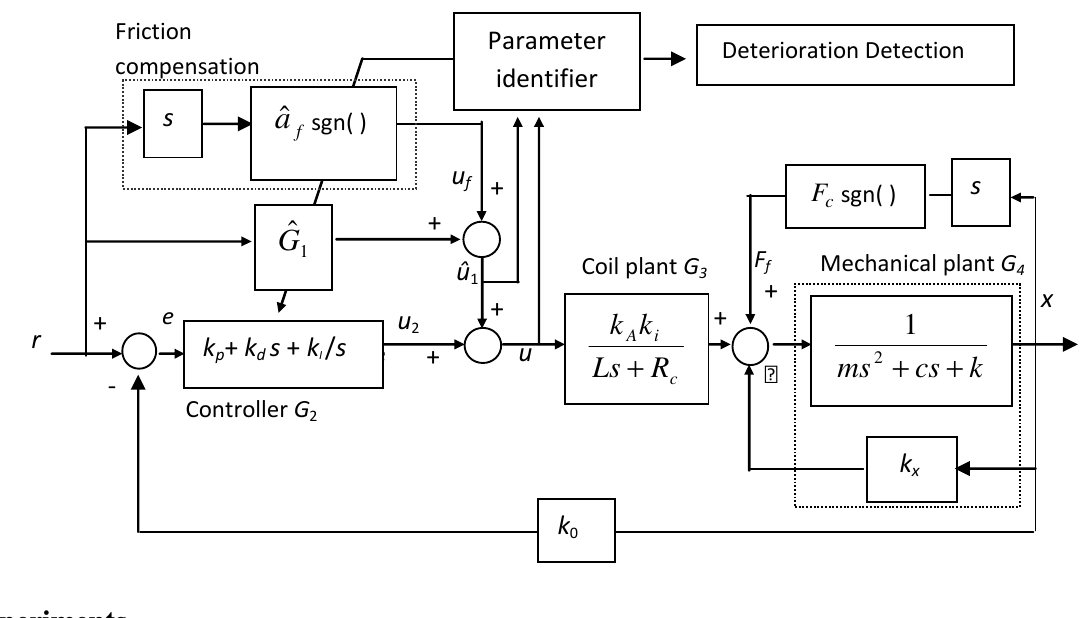
Figure 1. Block diagram of the proposed diagnostic